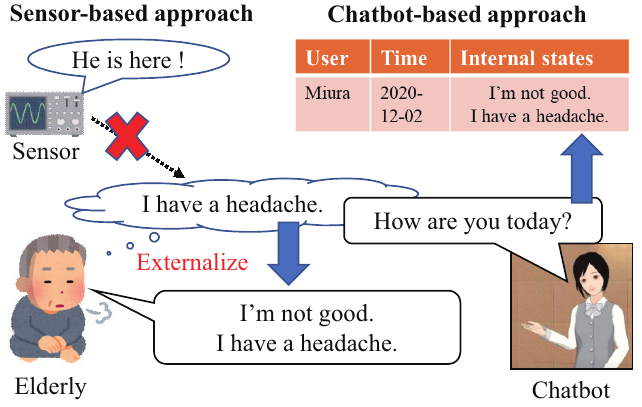
Figure 1. The comparison of the sensor-based and chatbot-based approach for elderly people. Copyright 2009–2018 Nagoya Institute of Technology (MMDAgent Motion “Info of Mei”).